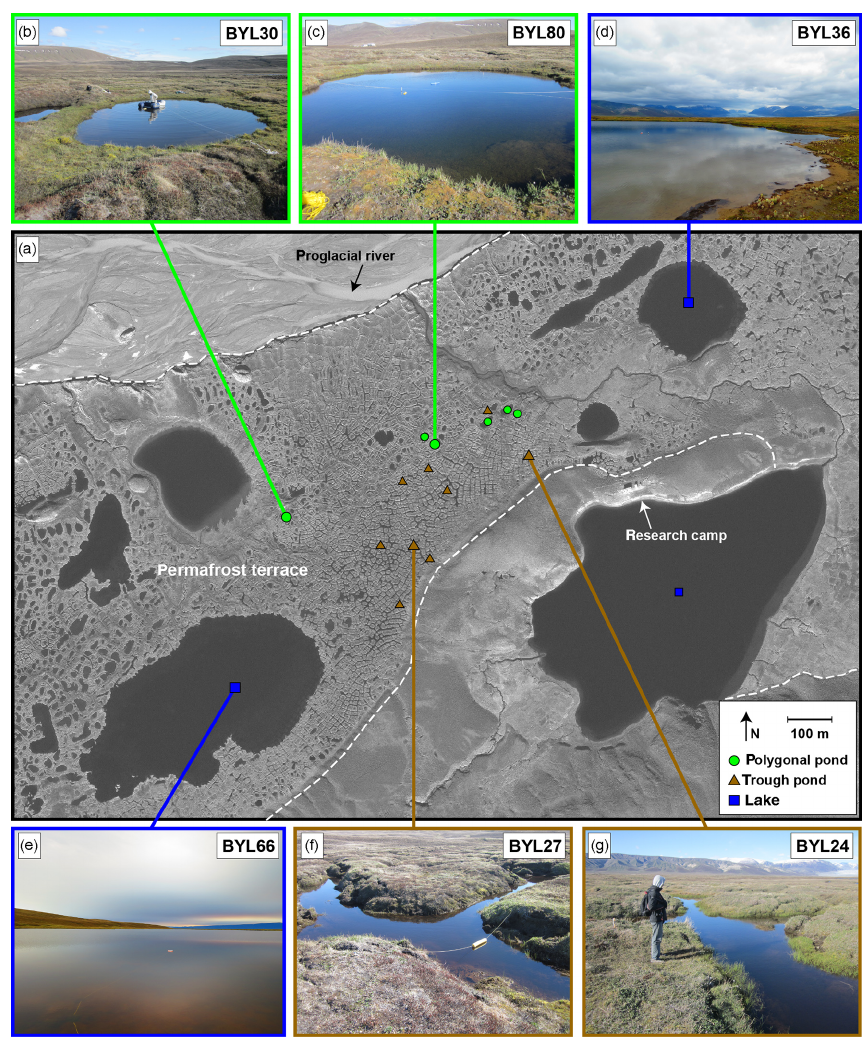
Figure 2. Location of the sampled water bodies (a) , including polygonal ponds (b–c) , kettle and thermokarst lakes ( d–e , respectively) and trough ponds (f–g) . Ponds and lakes are located within the limits of a peaty loess permafrost terrace, outlined with the dashed white line. Satellite photo (a) : GeoEye-1, 18 July 2010.